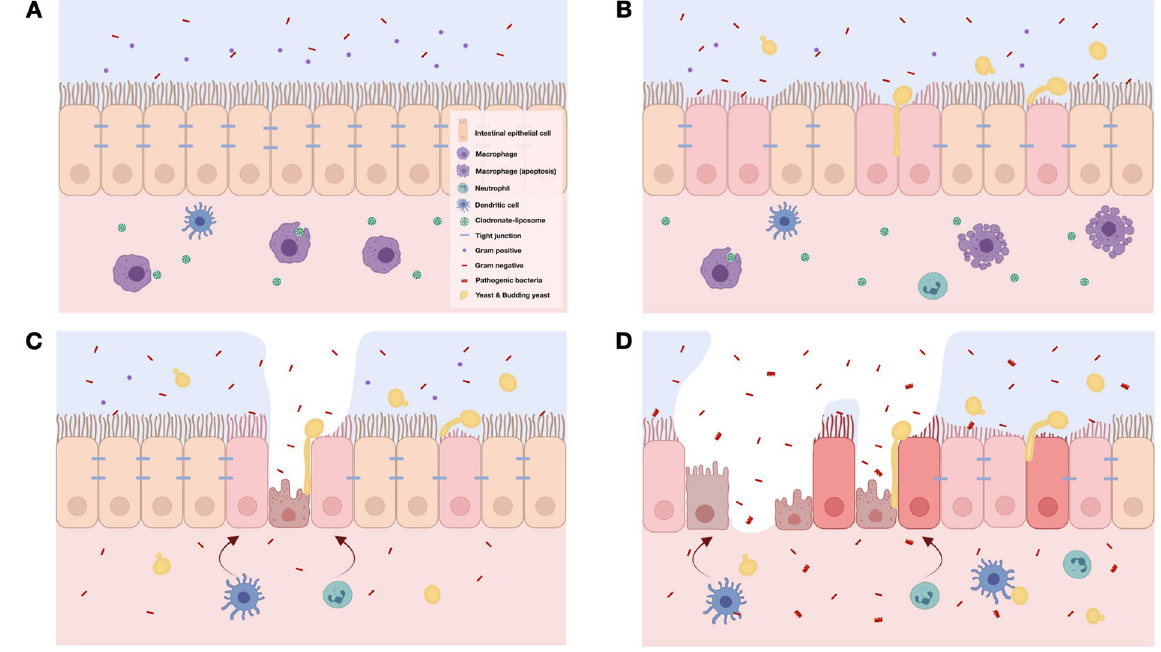
Figure 11. The working hypothesis demonstrates a balance between immune responses, especially macrophage function, versus intestinal microbes in the mice with intact macrophage ( A ). Clodronate induces macrophage apoptosis and causes an overgrowth of gut fungi ( Candida pintolopesii ) in a later stage ( B ). In Clodronate- administered sham mice, macrophage depletion causes fungal overgrowth and enhances bacteria with a less virulence, particularly Enterococcus faecalis , in gut causing a mild degree of gut permeability defect through enterocyte tight junction damage or enterocyte cell death ( C ). With cecal ligation and puncture (CLP) sepsis, sepsis induces an overgrowth of pathogenic bacteria (sepsis-induced gut dysbiosis), especially Gram-negative bacteria (Proteobacteria), and gut fungi which facilitates growth of some other strains of pathogenic bacteria results in a more severe gut leakage, bacteremia of the high virulence microbes and severe sepsis ( D ). The picture is created by BioRender.com (https:// app. biore nder. com/ illus trati